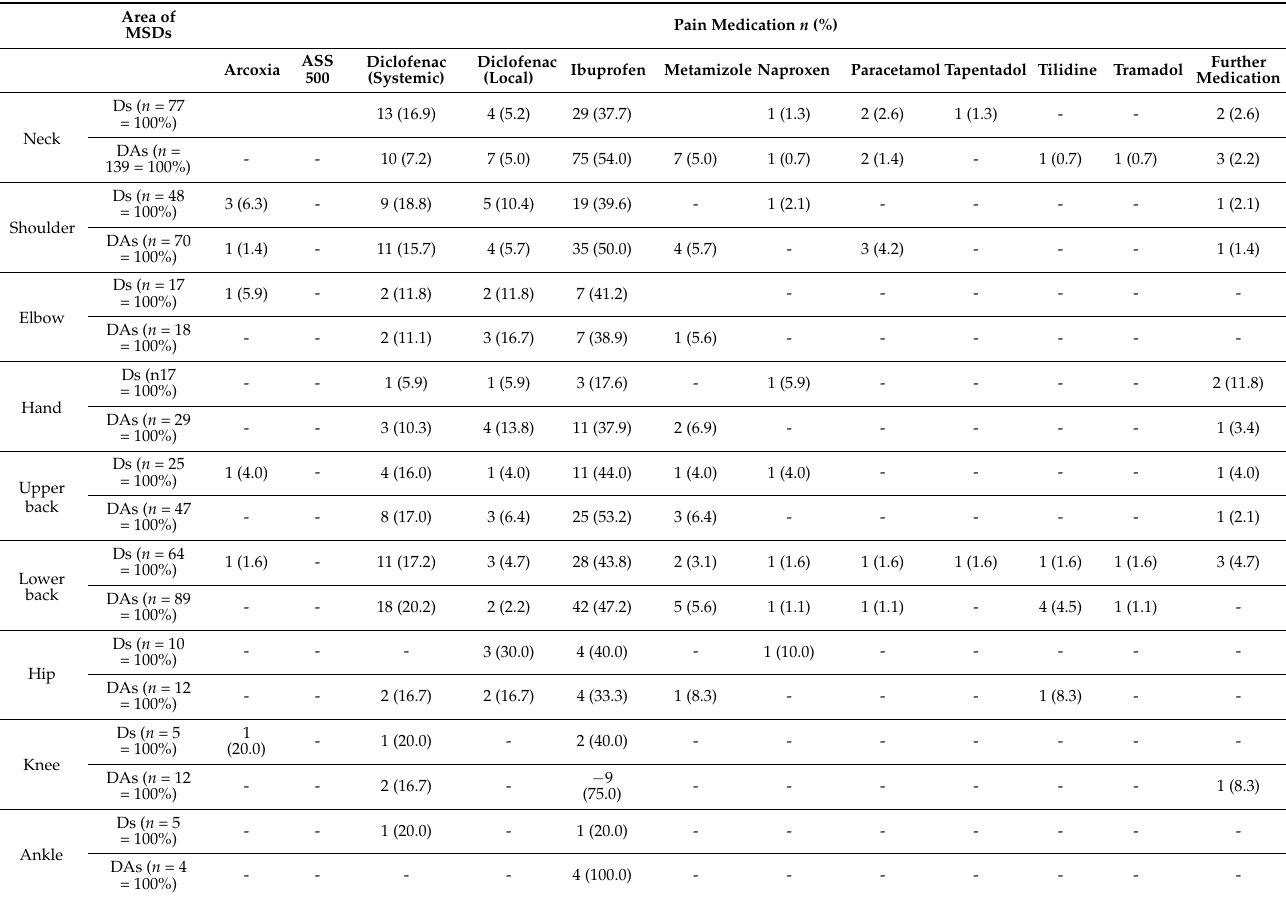
Table 5. Pain medication agents used to treat the MSDs of Ds and DAs, according to body region of Ds and DAs in n (%). Area of MSDs